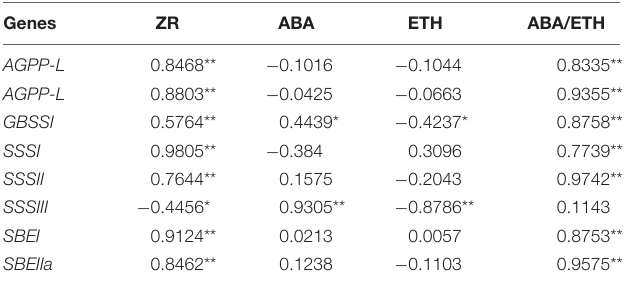
TABLE 2 | Correlation coefficients between the expression of genes and the levels of hormones, the ratio of ABA/ETH in wheat grains.